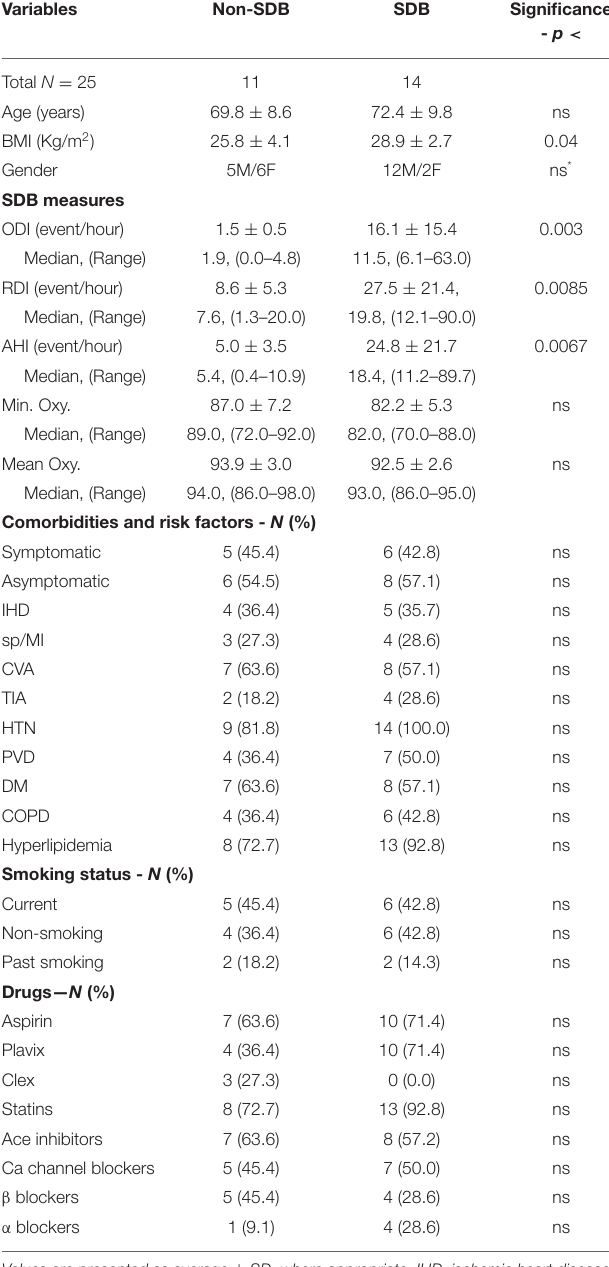
Values are presented as average ± SD, where appropriate. IHD, ischemic heart disease; s/p MI, status post myocardial infarction; CVA, stroke or cerebrovascular accident; TIA, transient ischemic attack; HTN, hypertension; PVD, peripheral vascular disease; DM, diabetes mellitus; COPD, chronic obstructive pulmonary disease. * Gender differences were not statistically different using Fisher’s exact test.